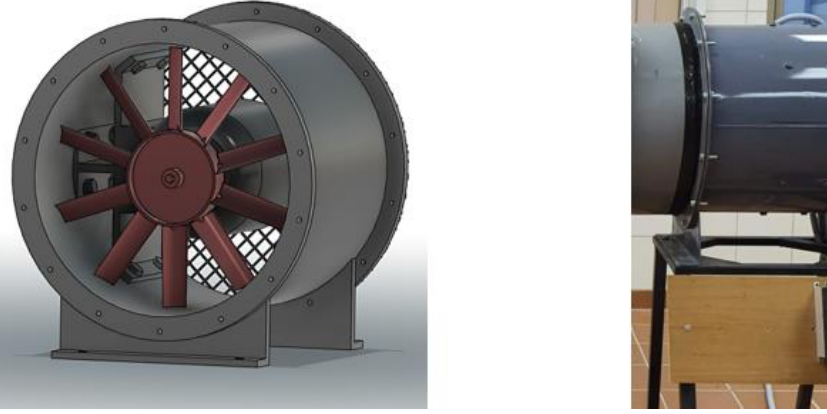
Figure 2. Typical axial fan and 3-D model of a driving unit with an axial fan.